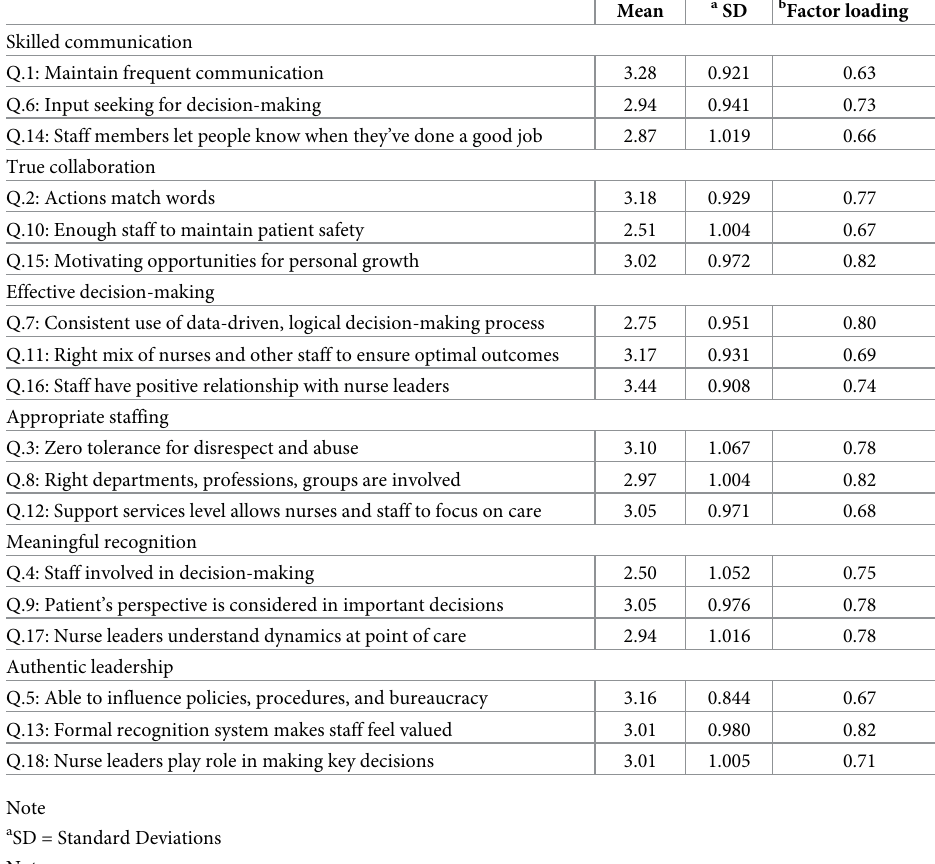
Table 2. Means, standard deviations for each questionnaire and factor